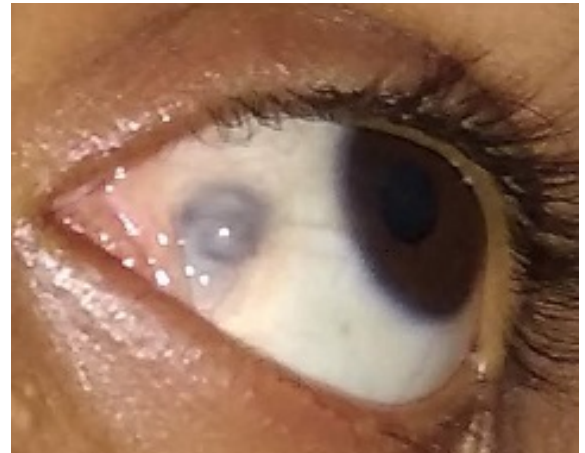
Figure 4: Resolved inflammation with formation of